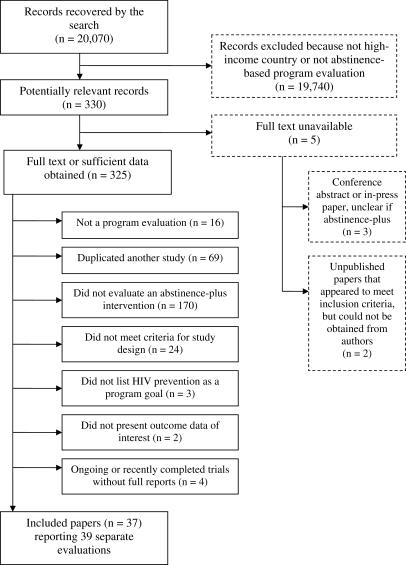
Flow Chart of Search Results